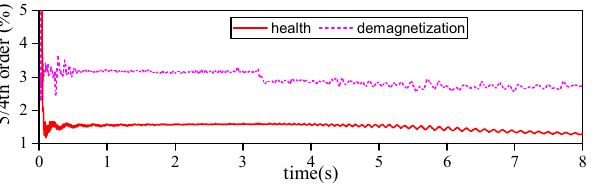
Figure 11. Comparison of 2/4th-order harmonic between partially demagnetized and healthy PMSMs under nonstationary conditions (experiment).